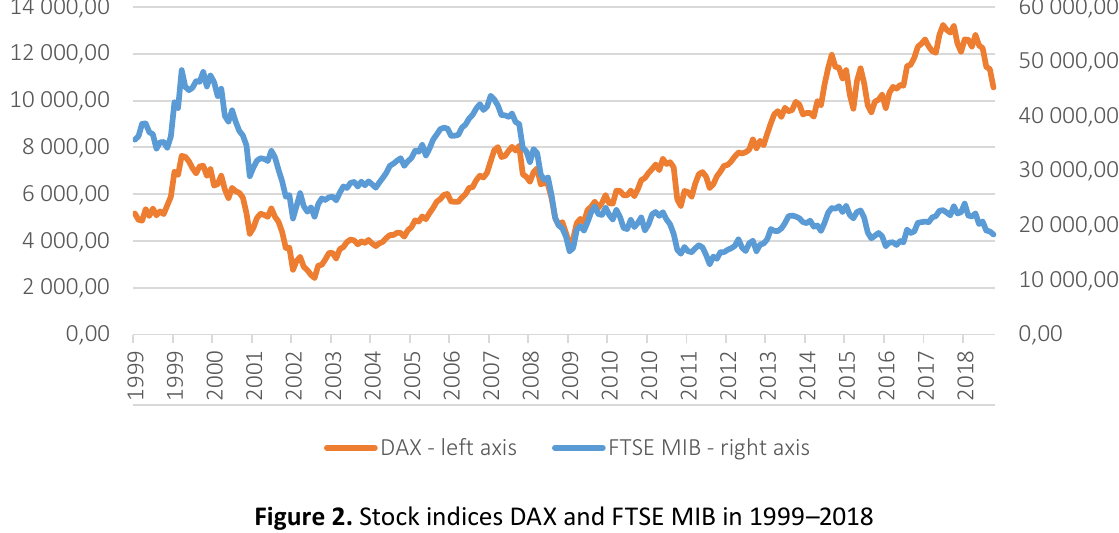
Figure 2. Stock indices DAX and FTSE MIB in 1999–2018